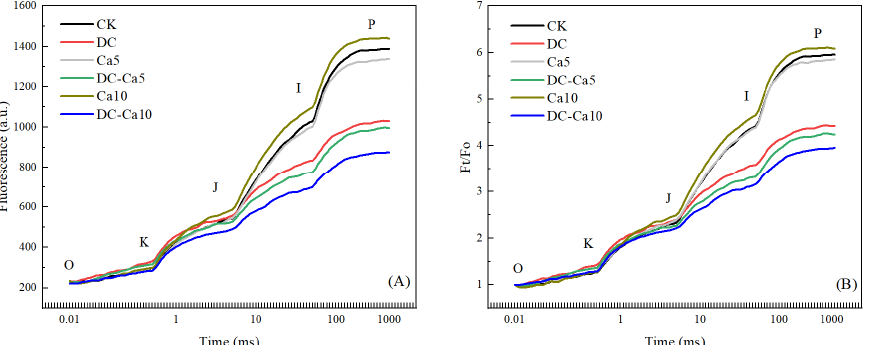
Figure 3. Chlorophyll a fluorescence OJIP transient curves of Pinus sylvestris var . mongolica exposed to well water, water stress, and different calcium concentrations, descripting the fluorescence rise from Fo (O) to Fm (P). Chl a fluorescence transient curves exhibiting fluorescence intensity (a.u.: arbitrary unit; ( A ) normalization at Fo (Ft/Fo); ( B ) CK: Control; DC: drought; Ca5: 5 mM Ca 2+ ; DC- Ca5: combined drought and 5 mM Ca 2+ ; Ca10: 10 mM Ca 2+ ; DC-Ca10: combined drought and 10 mM Ca 2+ .